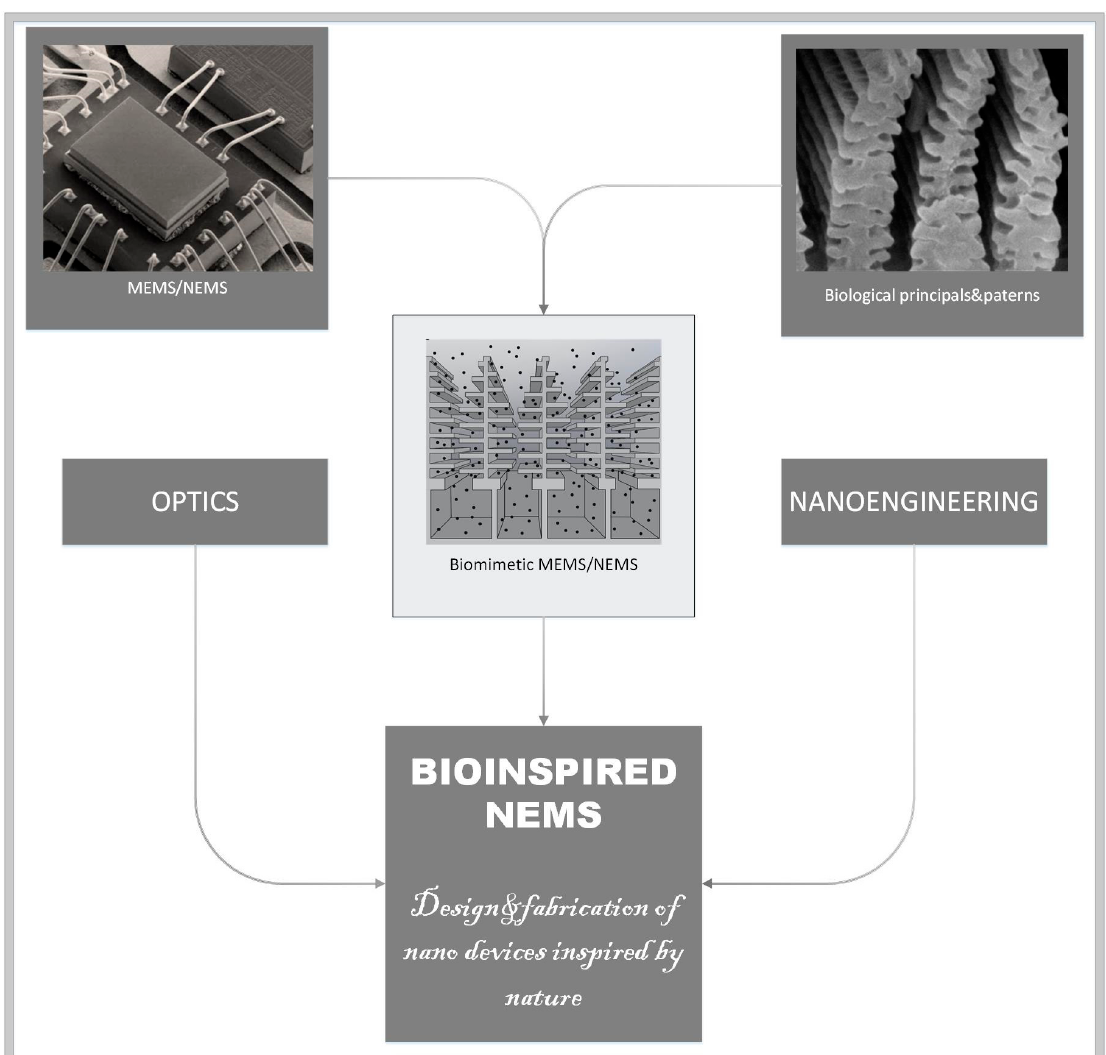
Figure 2. NEMS–Synergy of different technical approaches.